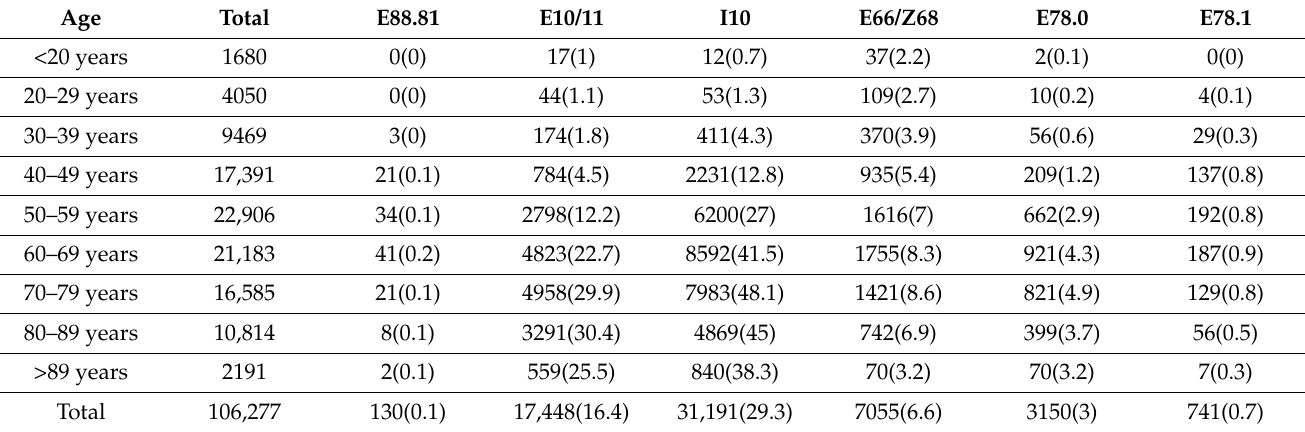
Table 8. Metabolic syndrome component frequency (95% CI) in all lithiasic patients.